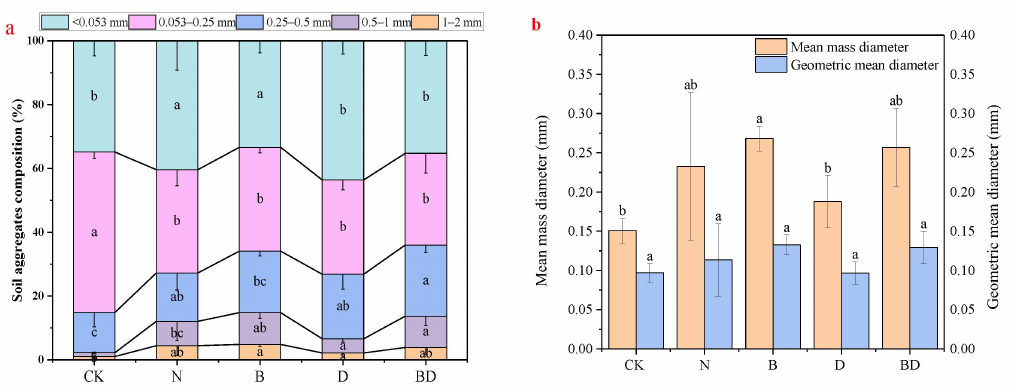
Figure 5. Effects of biochar and inhibitor addition on the soil’s aggregates ( a ) and structural stability ( b ). Small letters in the figure represent the significant difference among treatments ( n = 5, p < 0.05).